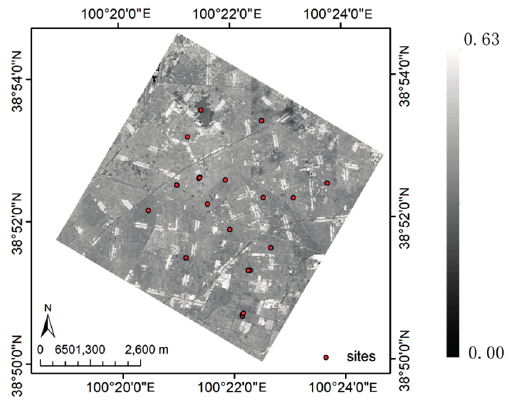
Figure 14. The CASI albedo of the foci experimental area (red points locate the AWS sites locations). Kipp and Zonen Net Radiometers (CNR4) mounted on automatic weather station (AWS)